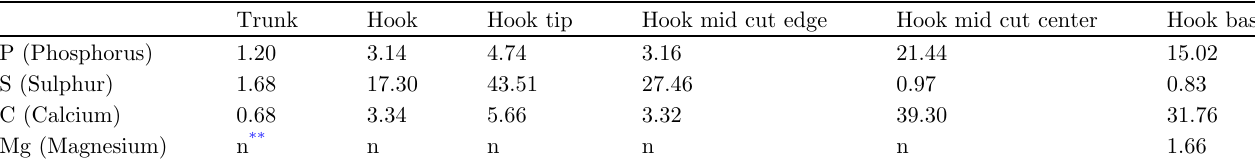
Table 3. X-Ray scans for hooks and trunk of Cavisoma magnum from Mugil cephalus. Trunk Hook Hook tip Hook mid cut edge Hook mid cut center Hook